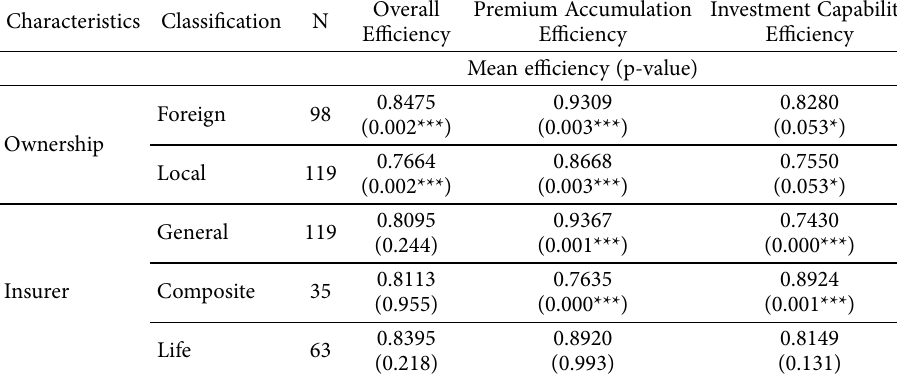
Table 7. Tests of differences on efficiency scores by insurer and ownership types Characteristics